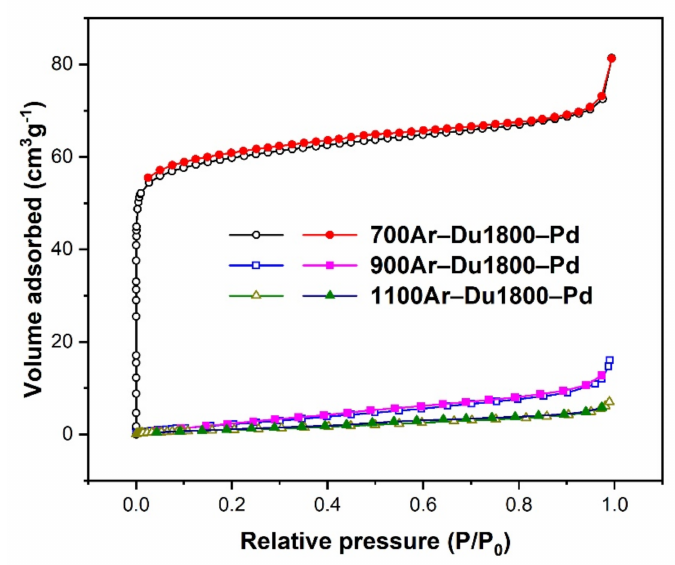
Figure 8. Nitrogen physisorption isotherms of the samples derived from Du1800-Pd precursor (open and filled symbols indicate the adsorption and desorption stage, respectively).